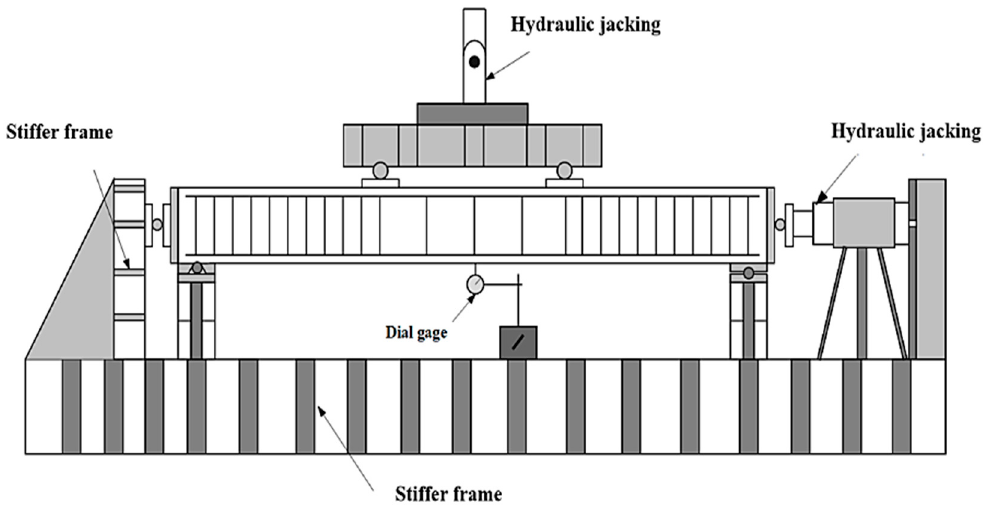
Figure 4. Sketch of modified testing machine.